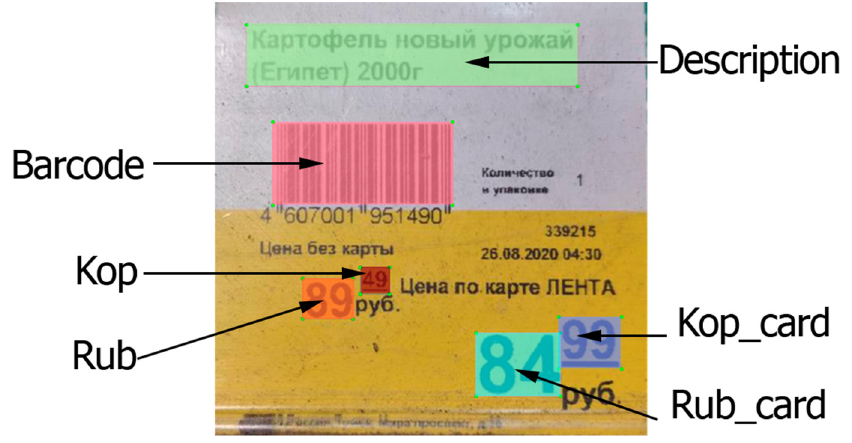
Figure 1. Example of labeling.